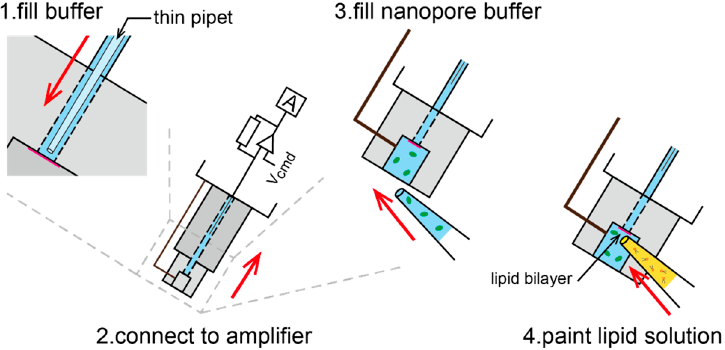
Figure 5. Procedure of a lipid-bilayer membrane formation on the microaperture in the mini-cup device. A painting method was used with 1,2-diphytanoyl- sn -glycero-3-phosphocholine (DPhPC) in n -decane (10 mg/mL) and a buffer solution (1 M KCl, pH 7.0).